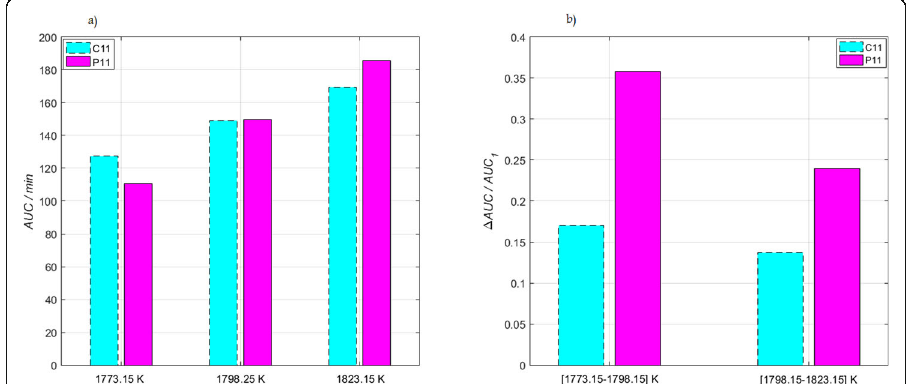
Fig. 4 a The comparison of quantity AUC of experimental data for reactions of MgO with charcoal and petcoke in molar ratio 1:1 and at different temperatures. b The comparison of quantity Δ AUC / AUC 1 of experimental data for reactions of MgO with charcoal and petcoke in molar ratio 1:1 and at different but isolength temperature